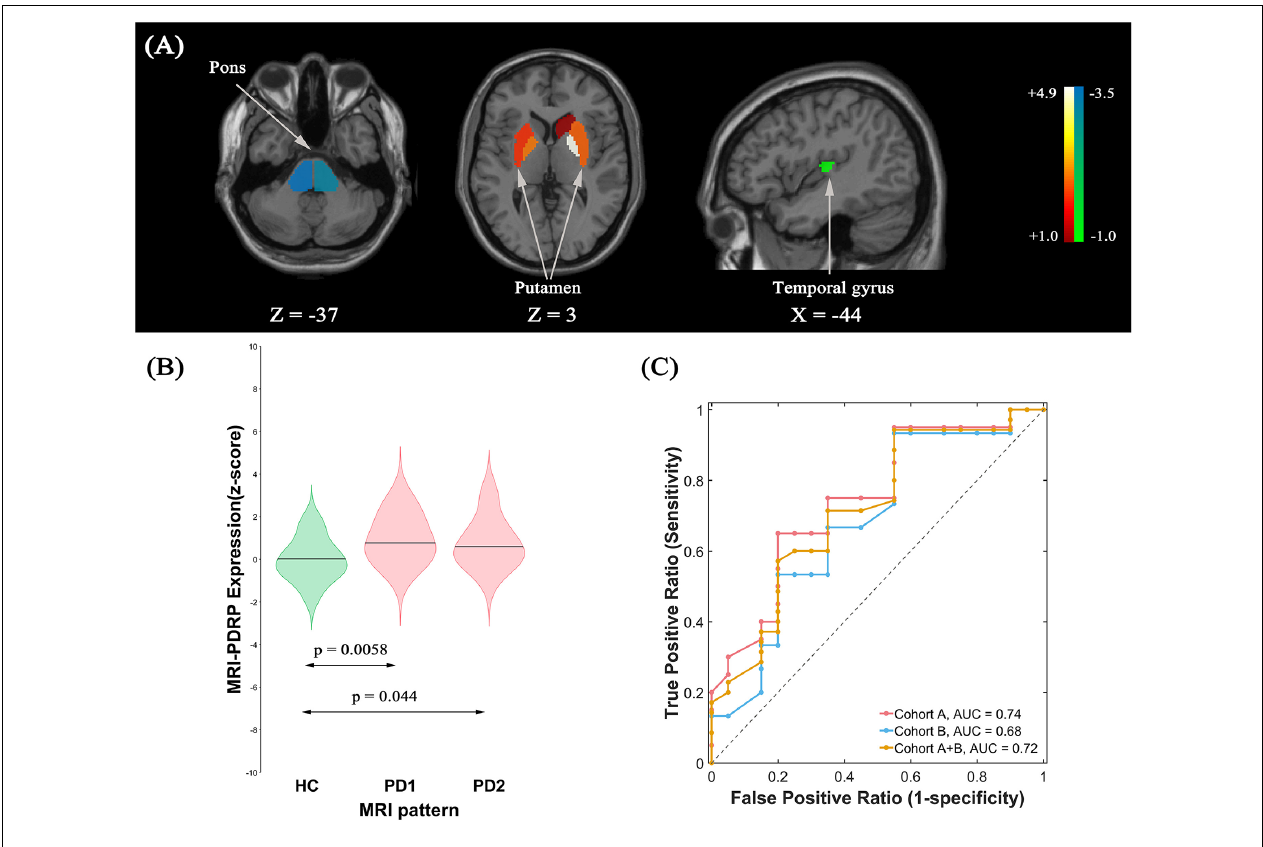
FIGURE 3 | (A) Structural Parkinson’s Disease-Related Pattern (MRI-PDRP) derived from the same subjects. The pattern was characterized by relative decreased gray matter (GM) volume in bilateral pons, bilateral transverse temporal gyrus, left cuneus, right superior occipital gyrus, and right superior parietal lobule, associated with preservation in GM volume in bilateral pallidum and bilateral putamen. (B) Subject expressions for the MRI-PDRP topography measured using violin plots in the HC, PD1 and PD2 scans (horizontal lines indicate group medians). Significant increases in pattern expression were seen in PD1 original derivation subjects and PD2 validation subjects with respect to HC control values. (C) ROC curve for discriminating PD patients from healthy